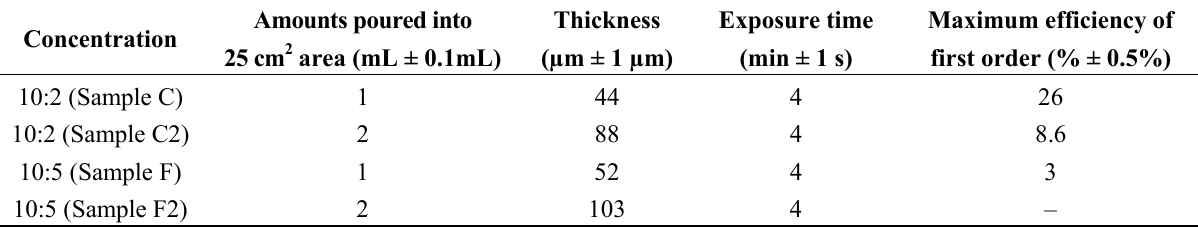
Table 3. Liquid solutions poured into a 25 cm 2 area to determine the thickness, at 25 °C and a relative humidity of